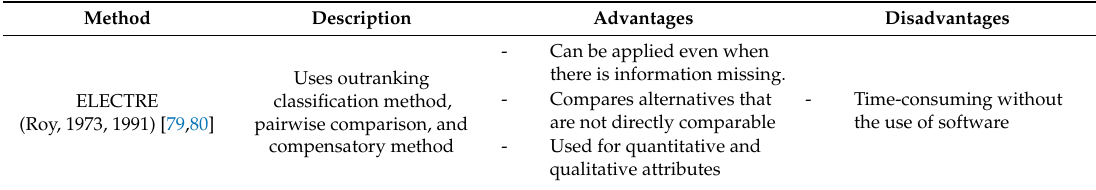
Table 2. Comparison of multicriteria decision-making methods.